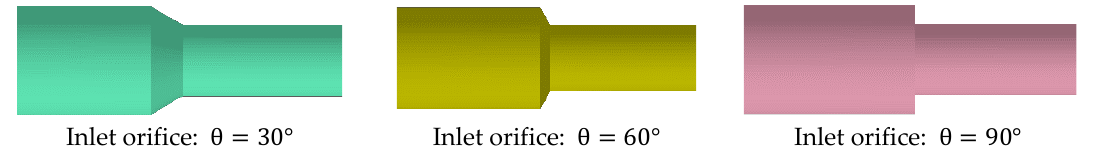
θ = 90° Figure 14. Schematics of inlet orifices with different angles. Note that only the outlet orifices are not